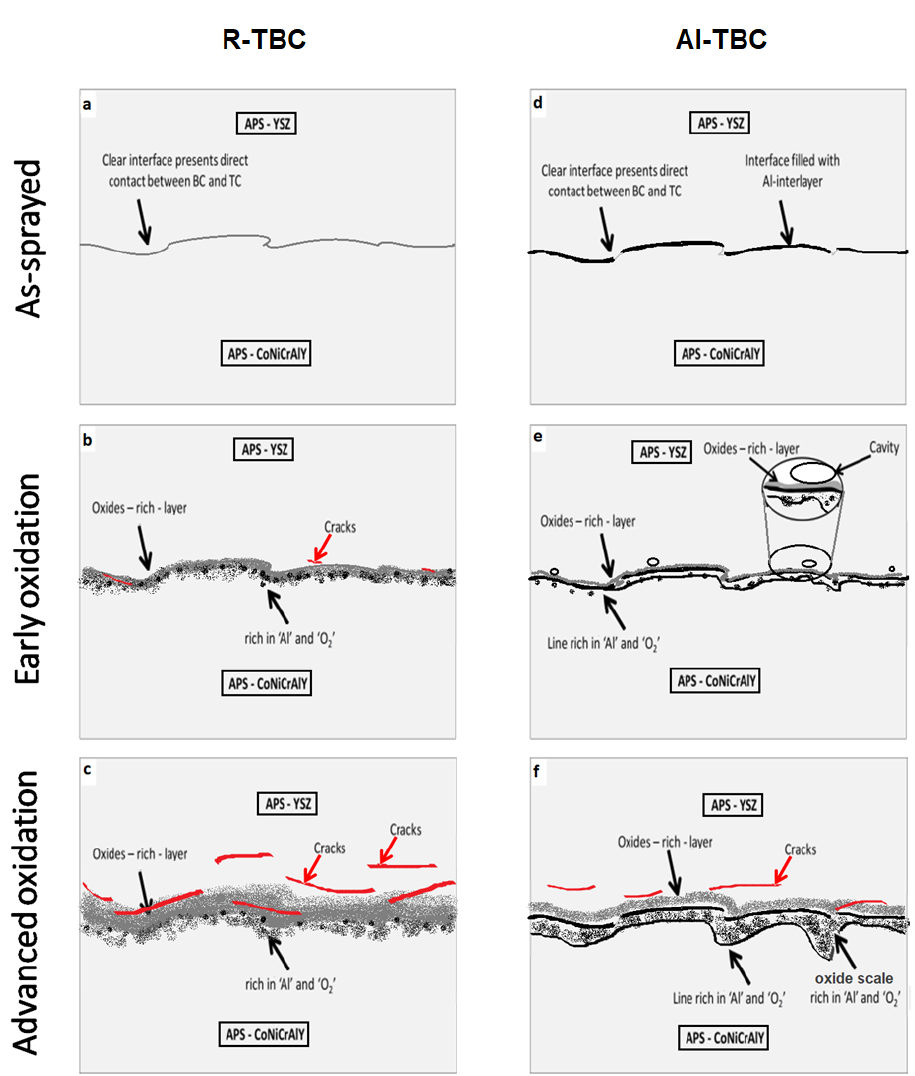
Figure 9. Schematic representation and comparison of the oxidation sequence for the TBC systems: ( a – c ) R-TBC; ( d – f ) Al-TBC. Mixed oxides are labelled in gray, Al-rich oxidase is labelled in black, and cracks are labelled with red.